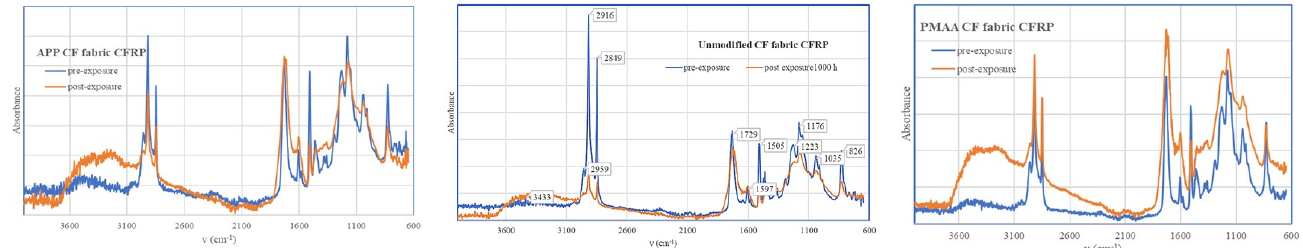
Figure 4. Comparative FT-IR spectrum pre-exposure (blue trace) and post exposure (orange trace). Table 7. Identification of peaks from FT-IR spectra [32,33].